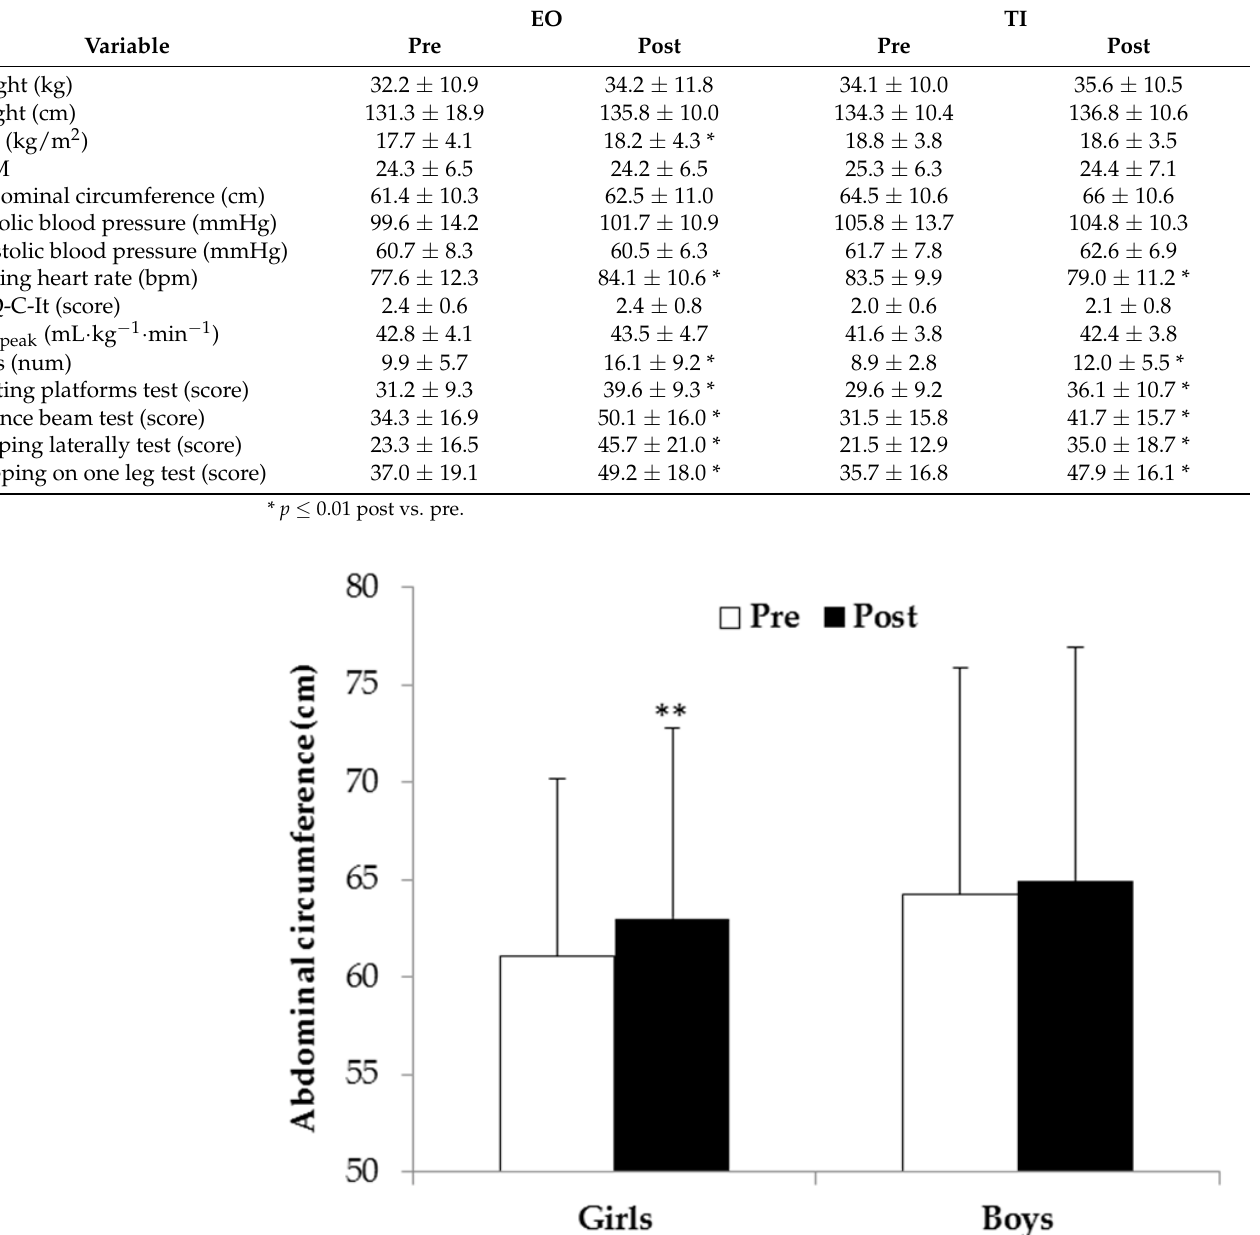
The main effect of gender (F higher resting HR than boys (82.5 ± 12 bpm vs. 79.4 ± 10.4 bpm, respectively). The time x group interaction (F 1,91 = 17.64, p < 0.0001, η 2 = 0.162) revealed that the EO group signifi- cantly increased resting HR, while the TI group significantly decreased resting HR rate after intervention (Table 2). The main effect of time revealed that children’s VO 2peak (F 1,102 = 27.70, p < 0.0001, η 2 = 0.214) (42.3 ± 4.0 ml . kg − 1. min − 1 vs. 43.1 ± 4.4 ml . kg − 1. min − 1 ) and laps number (F 1,101 = 82.91, p < 0.0001, η 2 = 0.451) (9.5 ± 4.7 num vs. 14.5 ± 8.1 num) significantly increased after inter- vention. The main effect of group (F 1,101 = 4.48, p = 0.037, η 2 = 0.042) revealed that the EO group performed a greater number of laps than the TI group (13.0 ± 8.2 num vs. 10.5 ± 4.6 num, respectively). The main effect of gender revealed that girls had lower VO 2peak (F 1,102 = 6.56, p = 0.012, η 2 = 0.060) (41.7 ± 3.4 ml . kg − 1. min − 1 vs. 43.7 ± 4.6 ml . kg − 1. min − 1 , respectively) and performed a lower number of laps (F 1,101 = 4.75, p = 0.032, η 2 = 0.045) (10.8 ± 5.4 num vs. 13.2 ± 8.3 num, respectively) than boys. The time × group interaction (F 1,101 = 8.57, p = 0.004, η 2 = 0.078) revealed that the EO group showed a higher increase of laps number than the TI group after intervention (Table 2). The time × gender interaction (F 1,102 = 5.05, p = 0.027, η 2 = 0.047) revealed that boys had a higher increase of VO 2peak than girls after intervention (Figure 2).